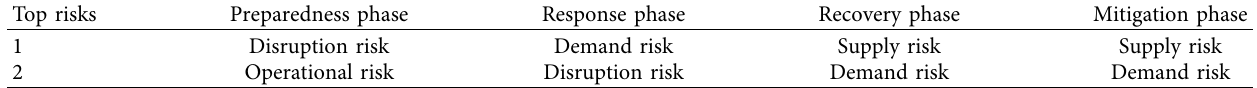
Table 6: Summary of the top two dominant risks in each DMC phase.